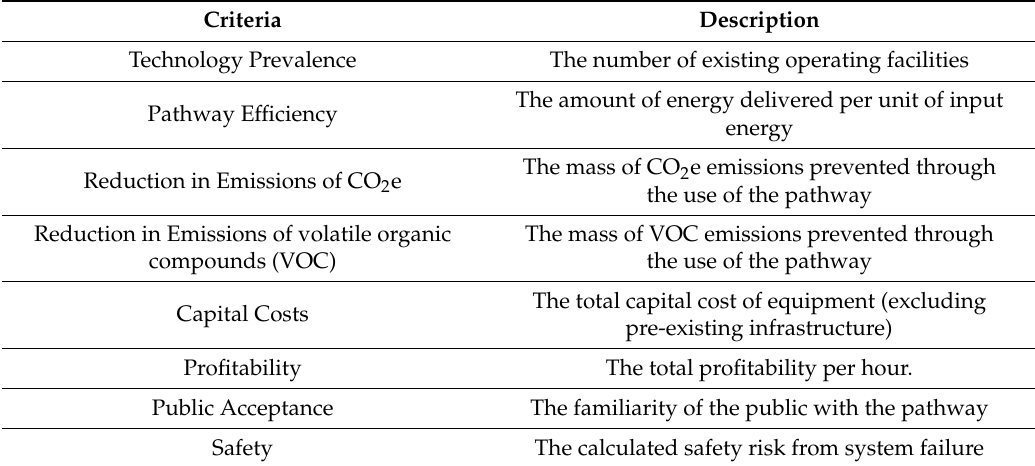
Table 2. Criteria for the Analysis of power-to-gas